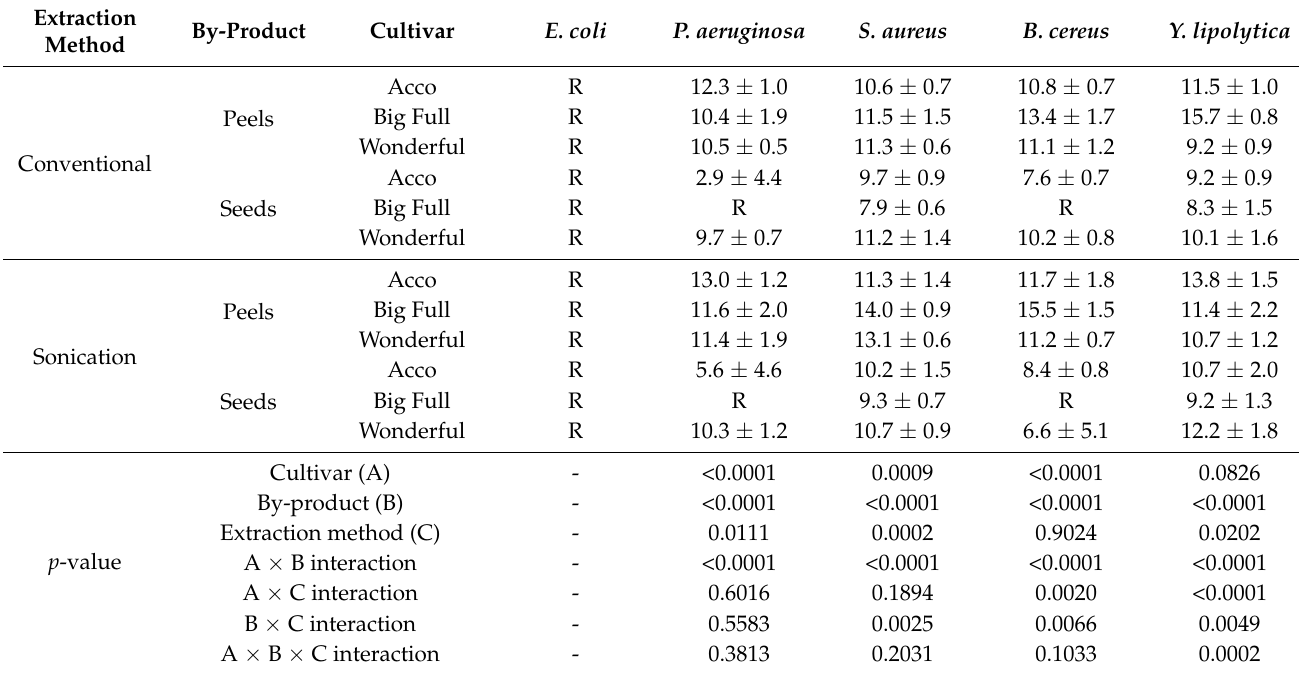
Table 4. Inhibition halos (mm) for each extract vs. microorganism